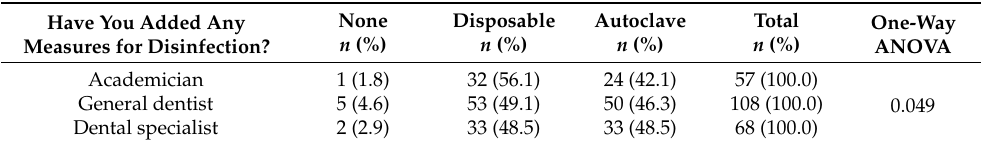
Table 1. Differences between autoclavable and disposable measures added by different groups of dentists. Have You Added Any Measures for Disinfection?